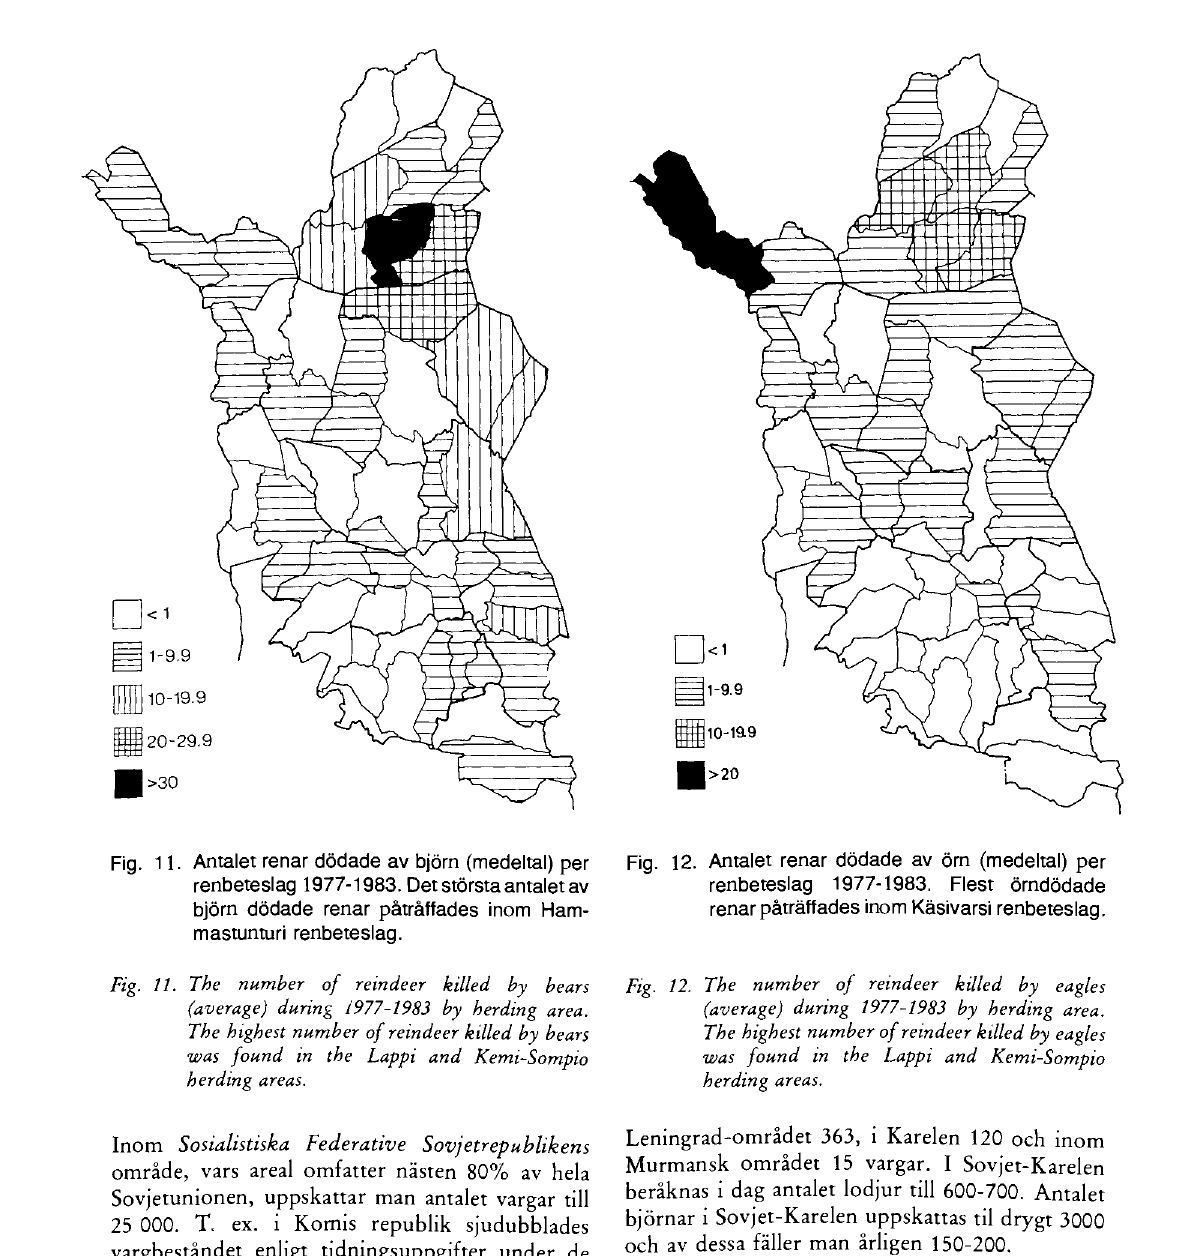
Fig. 12. Antalet renar dödade av örn (medeltal) per renbeteslag 1977-1983. Flest örndödade renar påtraffades inom Käsivarsi renbeteslag. Fig. 12. The number of reindeer killed by eagles (average) during 1977-1983 by herding area. The highest number of reindeer killed by eagles was found in the Lappi and Kemi-Sompio herding